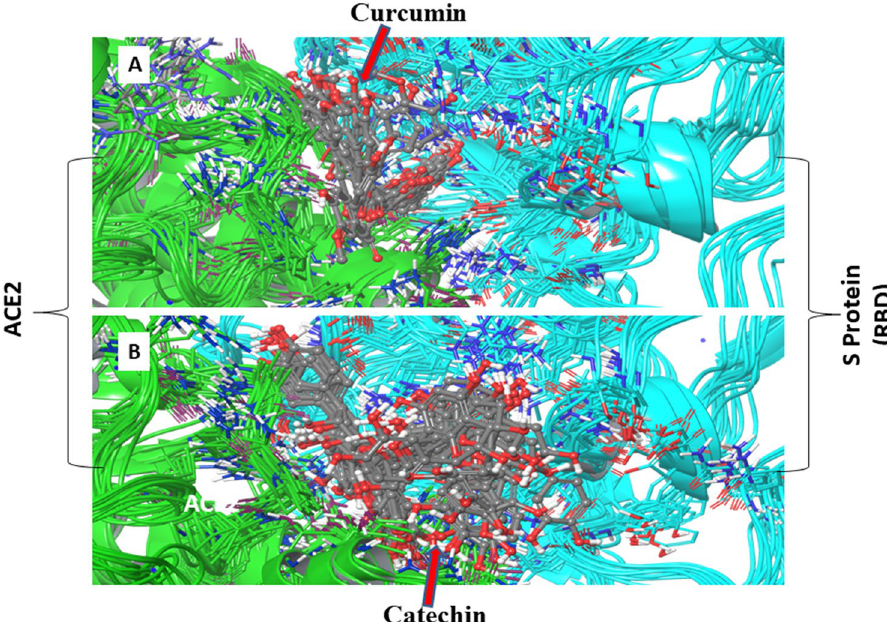
Figure 10. Superimposition of mutliple snapshots taken during interaction of ( A ) curcumin and ( B ) catechin with RBD/ACE2-complex, derived from the 100 ns of MD simulations at 10 ns